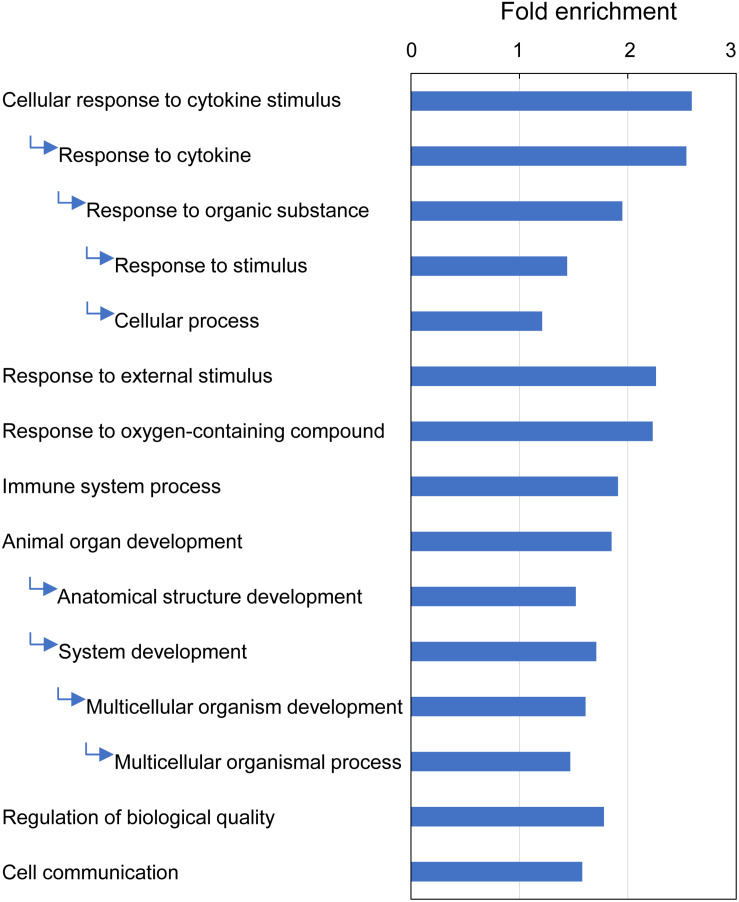
Top GO terms (Biological Process) associated with differentially expressed genes (DEGs) in Atlantic salmon gills with moderate histopathology (sites A and B) vs low histopathology (site C). The analysis was performed on 311 salmon genes mapped to 235 human orthologs, using PANTHER overrepresentation test and Bonferroni-corrected P-value < 0.05. The GO terms are sorted by the fold enrichment of the most specific categories, with their parent terms indented directly below. For details and list of corresponding genes see Supplementary Table 11.